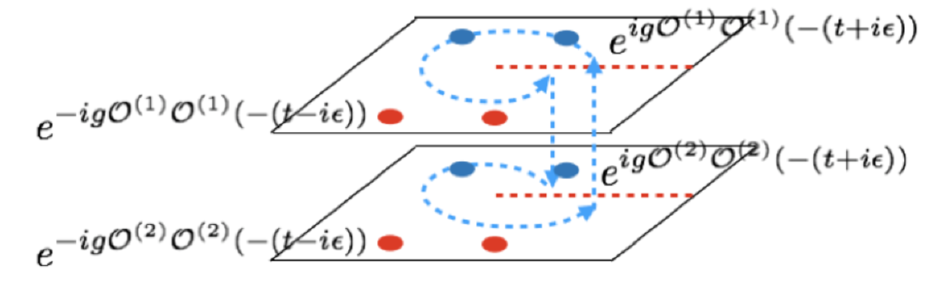
Figure 11 . Geometry of replica (cid:6) 2 . Blue points correspond to e ig OO ( (cid:0) ( t + i(cid:15) )) , and red points correspond to e ig OO ( (cid:0) ( t (cid:0) i(cid:15) ))